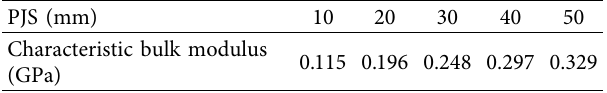
Table 10: Relationship between CBM and PJS.